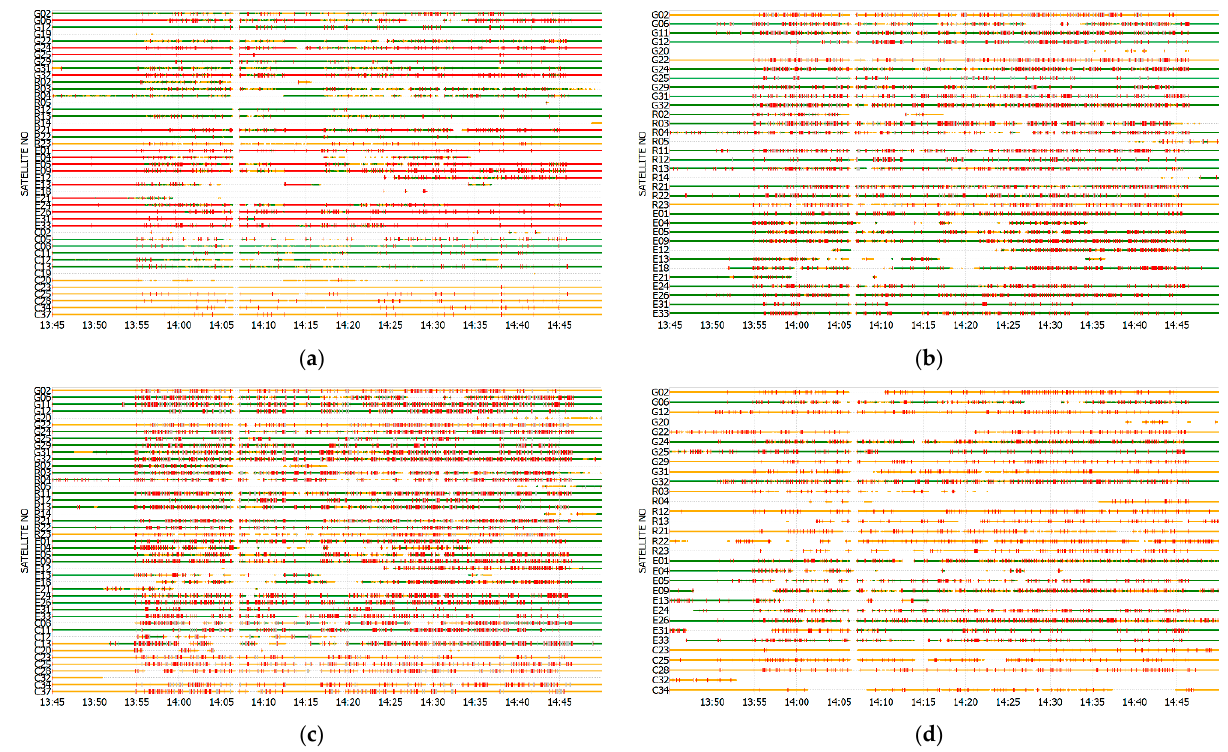
Figure 7. Satellite visibility, cycle slips (vertical red lines), and carrier-to-noise ratio (C/N0) for ( a ) Septentrio AsteRx-U receiver, ( b ) ZED-F9P u-blox receiver, ( c ) ZED-F9R u-blox receiver, and ( d ) Xiaomi Mi8. C/N0 values are shown in a colour scale from green (45 dB-Hz), orange, purple, blue, red (25 dB-Hz) to grey (<25 dB-Hz).